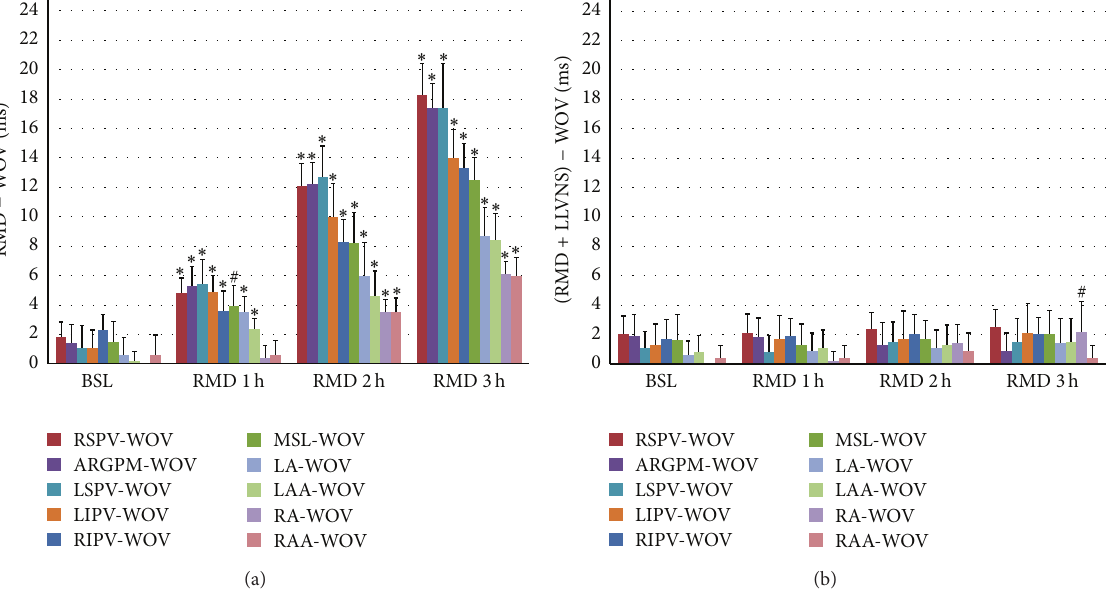
Figure 4: Effects of LLVNS on WOV and its gradient. LLVNS reversed the increase in WOV and its gradient caused by RAP. WOV: window of vulnerability; the remaining symbols and abbreviations are the same as those used in Figure